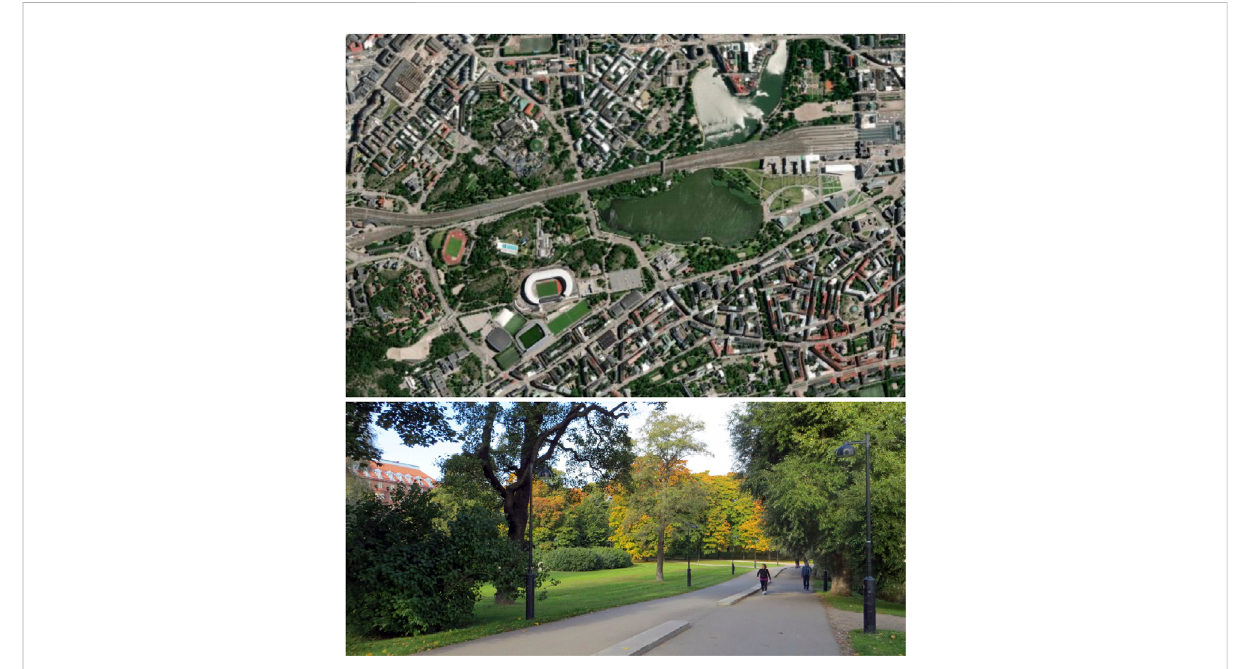
FIGURE 10 Social wellbeing urban greenspace characteristics. Hesperia Park. Orthophoto Top — BingMaps (2022). Photo bottom —